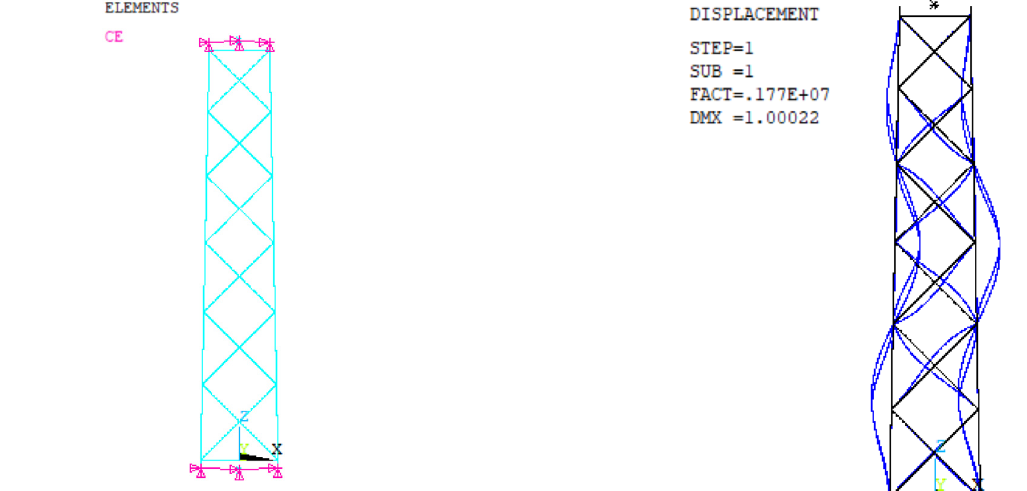
Fig. 5. Model establishment of variable cross-section top section and rigid coupling. Fig. 6. ANSYS buckling results of variable cross-section